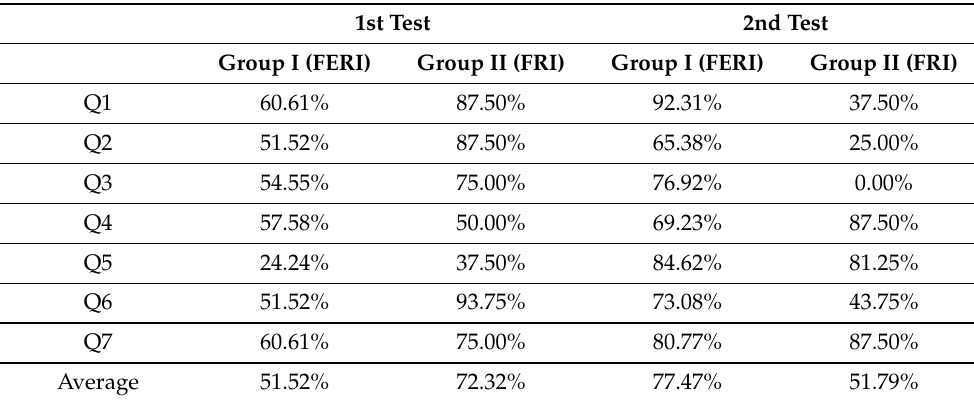
Table 5. Average correctness of tasks in both tests.